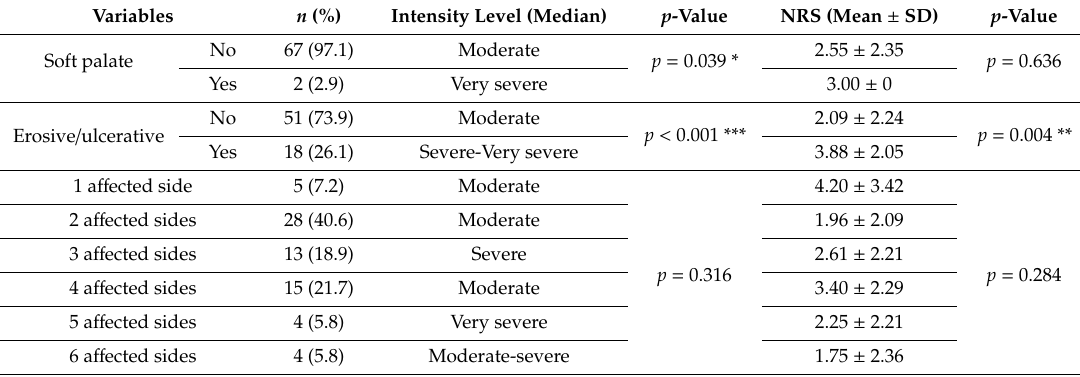
Table 3. Association of OLP involvement at soft palate, erosive / ulcerative OLP and number of a ff ected lesion sides with OHRQoL and pain perception ( n =